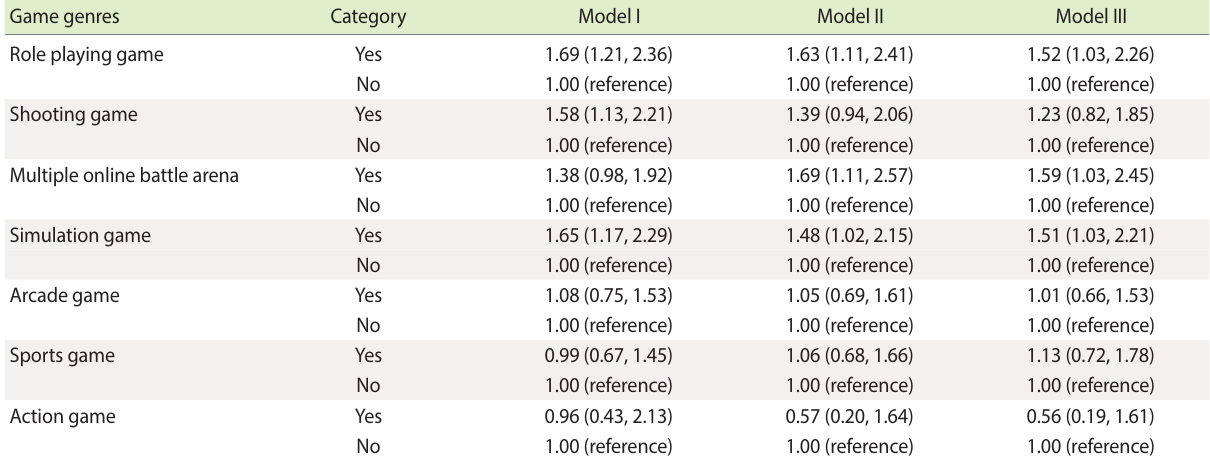
Table 3. Association between experience of game genre and risk of Internet gaming disorder